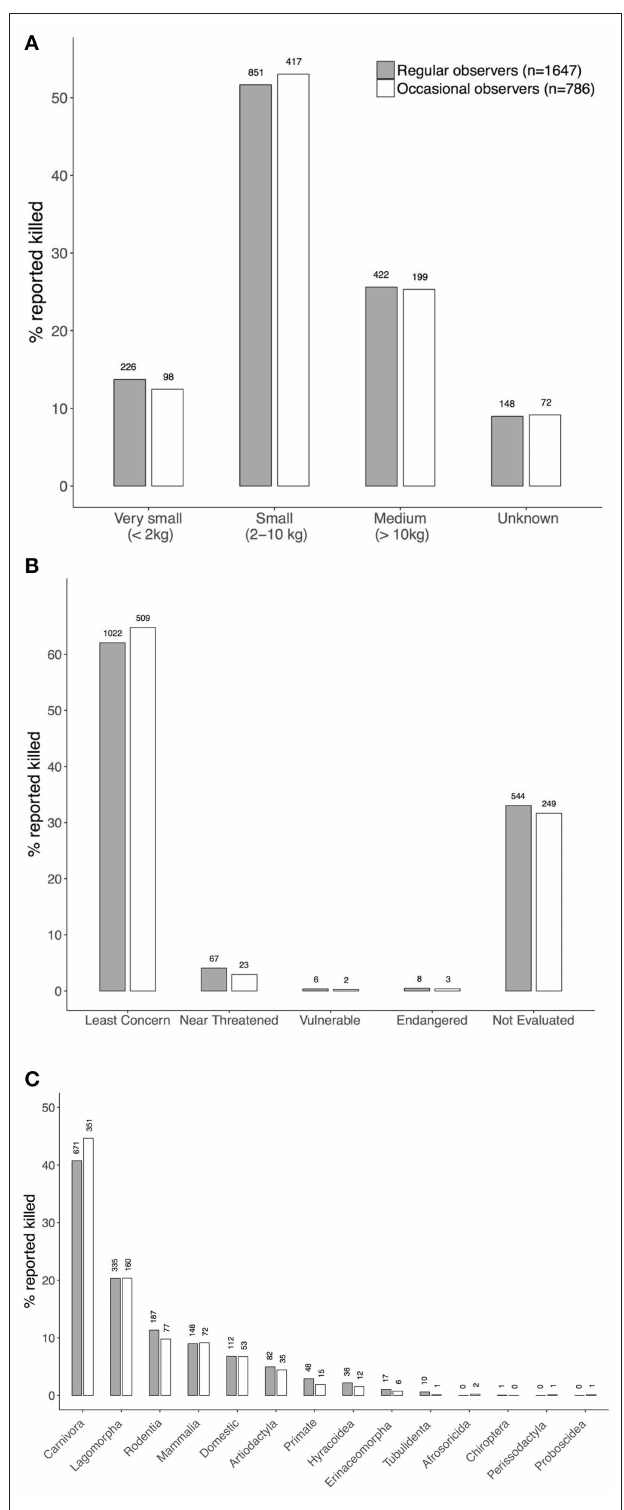
FIGURE 4 | Comparison of the distributions of (A) sizes, (B) Red List category of species and (C) taxonomic groups reported killed across South Africa by regular (gray) and occasional (white) observers. Figures above bars represent the number reported in each